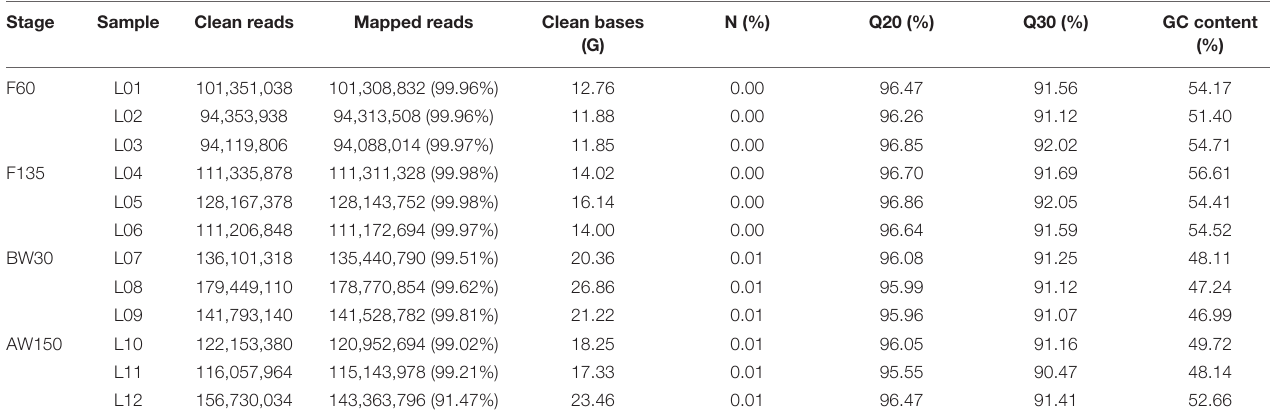
FIGURE 1 | General view of goat rumen tissue during fetal and prepubertal periods. Photomicrograph of rumen wall of the fetal goat at F60 (A) and at F135 (B) days of gestation, and at 30 (BW30) and 150 days (AW150) of age (C,D) , respectively. Bar, 200 µ m. TABLE 1 | Summary of circRNAs sequencing results in goat rumen tissues at four developmental